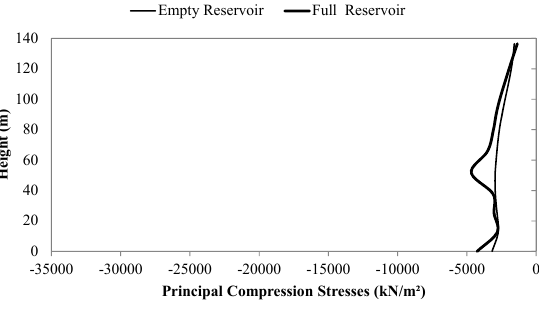
Fig. 20. The maximum principle stress components in II-II section.